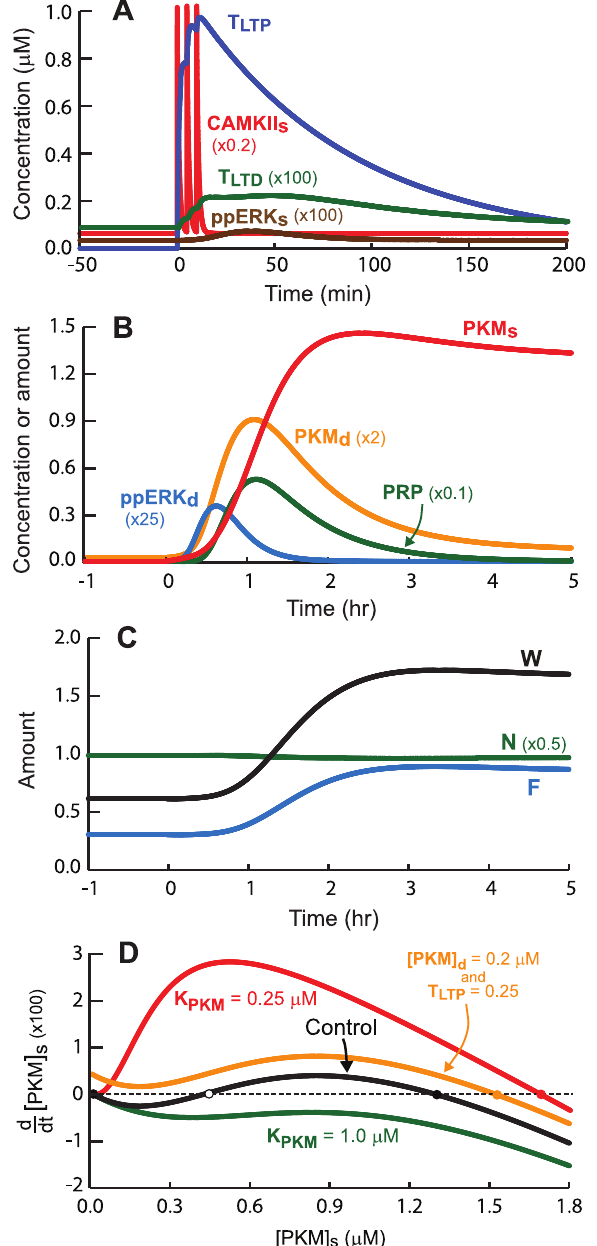
Figure 2. Simulated induction of LTP by STET. A , Time courses of active CaMKII s and ERK s , and the LTP and LTD tags. ERK s activity is the concentration of the doubly phosphorylated, active form of ERK s , ppERK